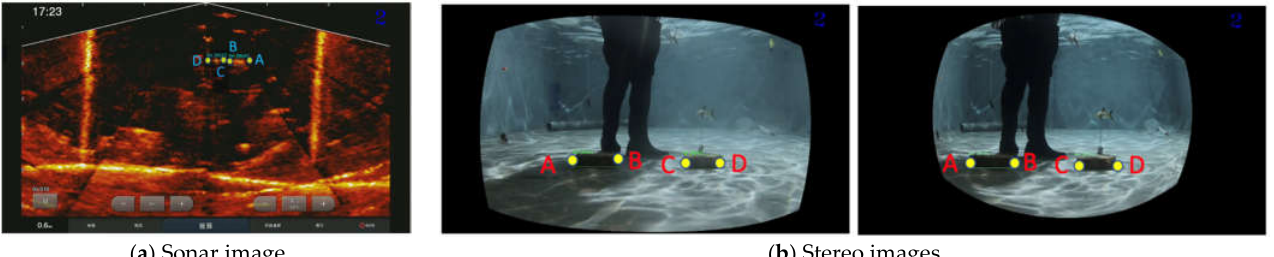
Figure 7. The sensor fusion consists of a stereo camera, and a sonar imaging device captures the fish images from a pond or a net cage. The 3D point clouds of the common object in the left image and the sonar image can be used to calculate the transformation matrix using a 3D affine transformation algorithm [54].